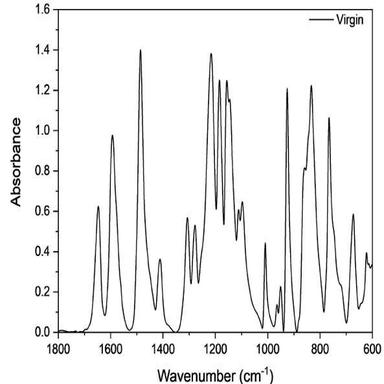
FTIR spectra of pure PEEK between 1800-600 cm− 1 (baseline-corrected and normalised to 1593 cm-1).